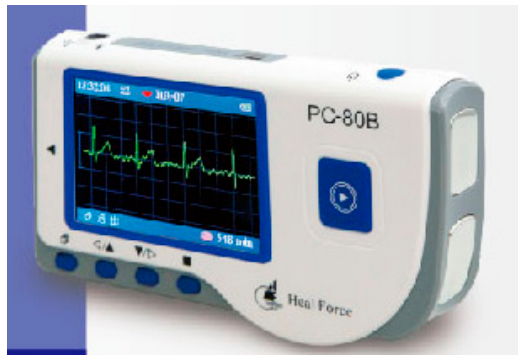
Figure 1. PC-80B high-speed electrocardio-signal detector.